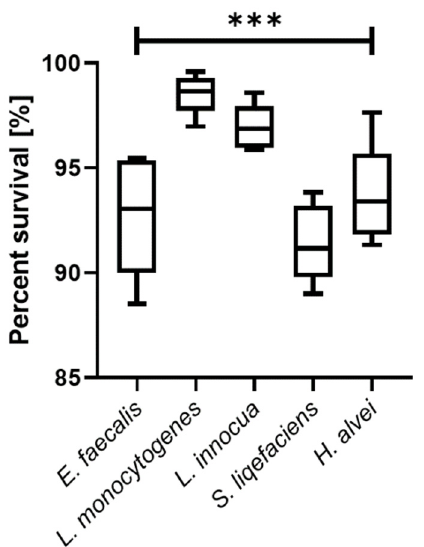
Figure 3. Reduction in the number of live cells of selected species of bacteria during the preparation of ceviche, ***— p < 0.0001.